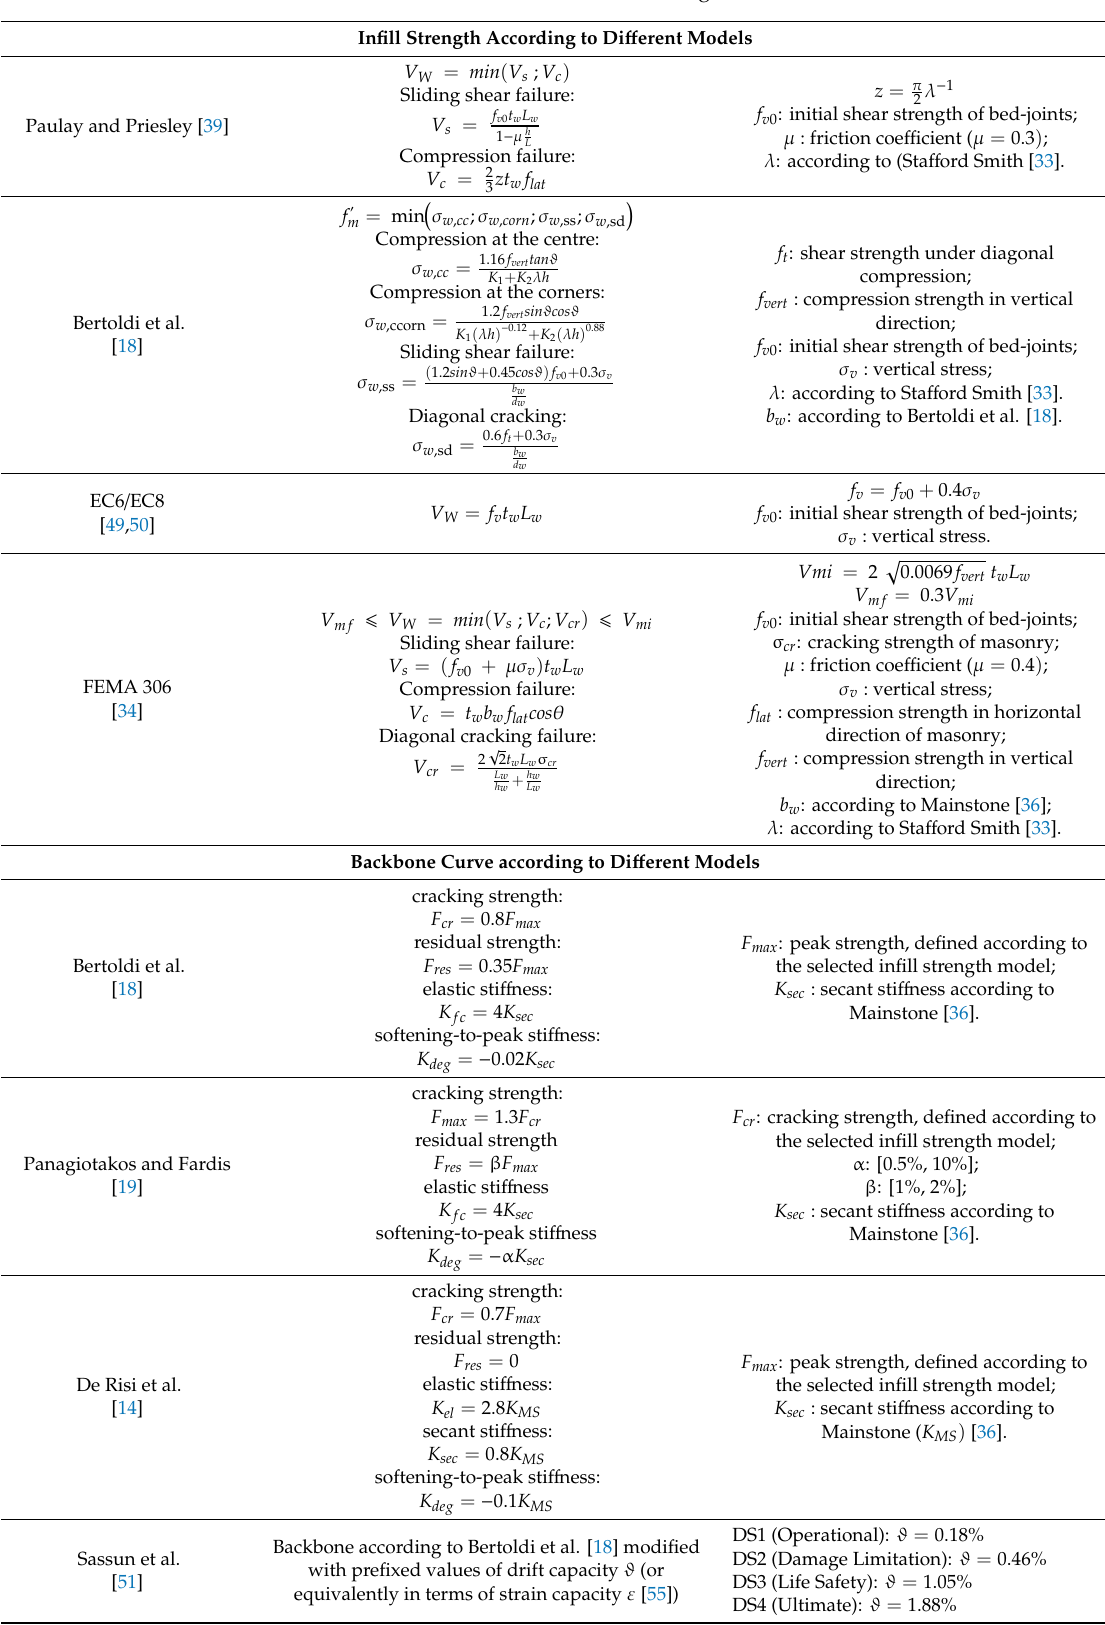
Table 2. Formulations for the evaluation of infill strength and backbone